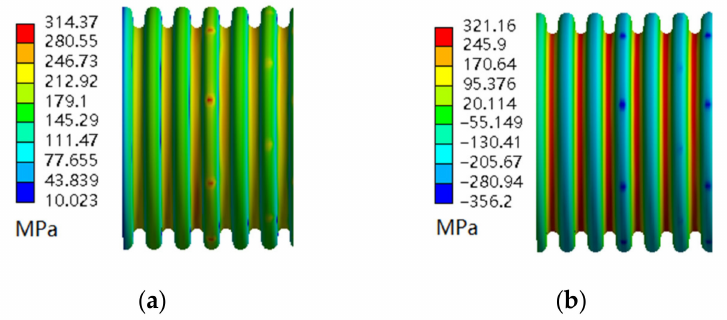
Figure 11. Stress diagrams of the DN25 bellows: ( a ) Equivalent stress, ( b ) Axial stress.